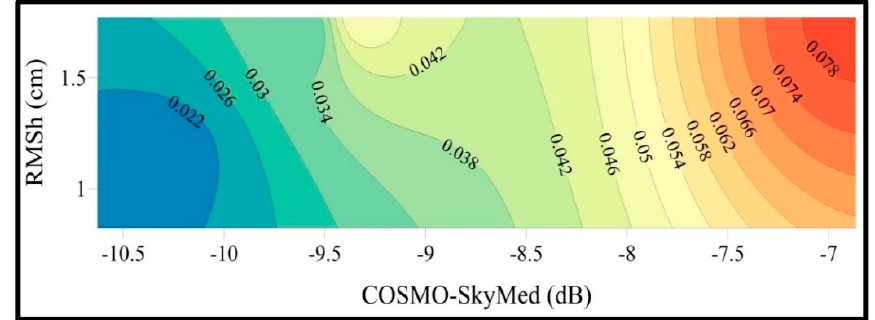
Figure 8. Schematic diagram that enabling the evaluation of Manning’s n values by using COSMO-SkyMed backscatter (dB). The blue color in the diagram represents low Manning’s n values (smooth surface), and the red color, high Manning’s n values (rough surface).